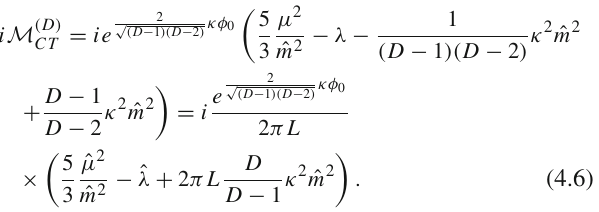
where the different lines correspond to the contributions